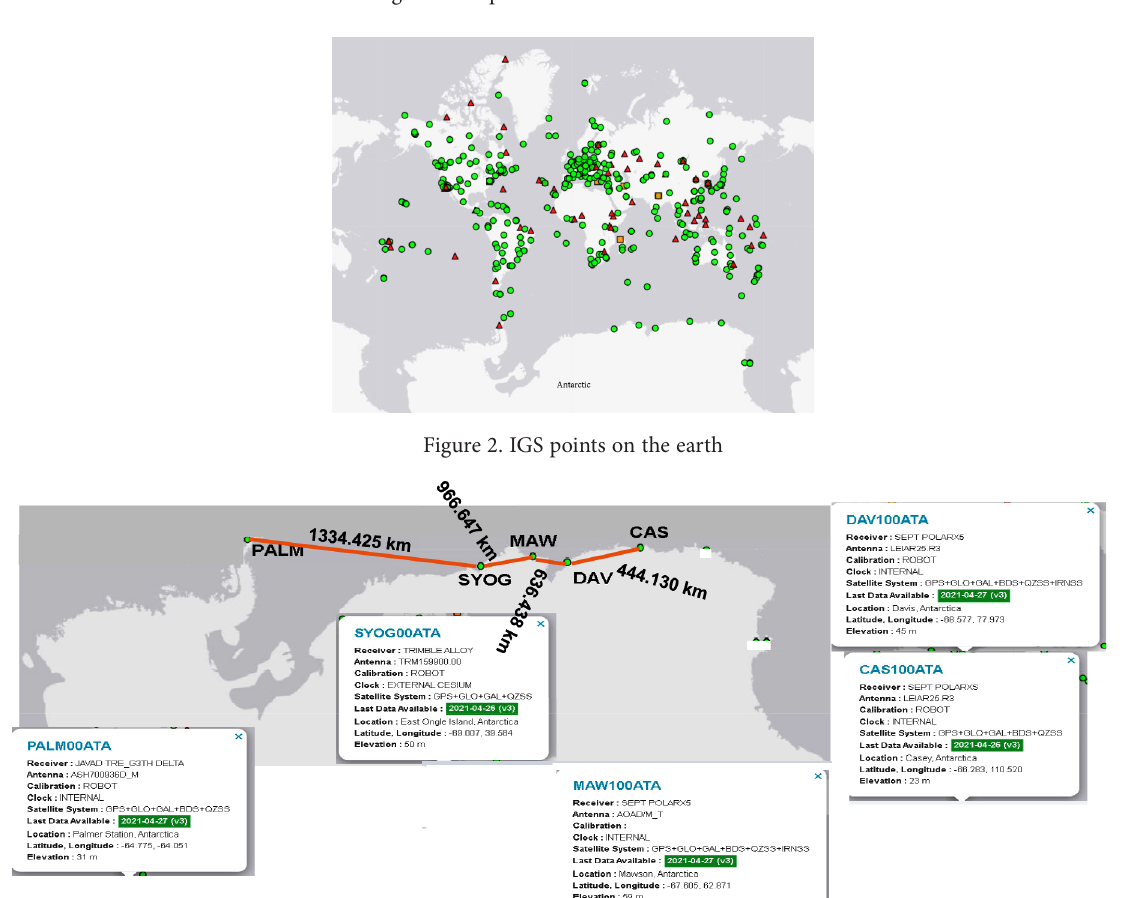
Figure 1. Map of the North and South Poles